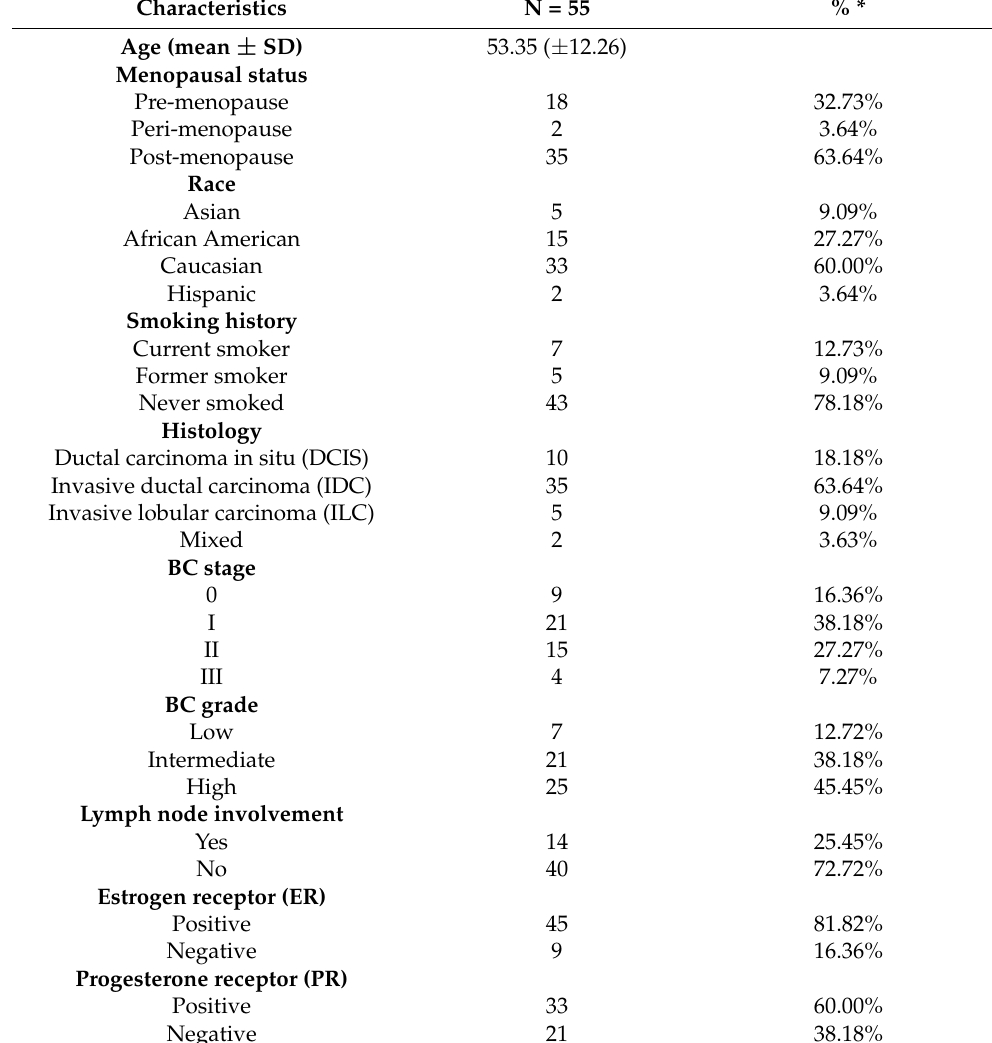
Table 1. Characteristics of the BC patients (N = 55) included in our study.